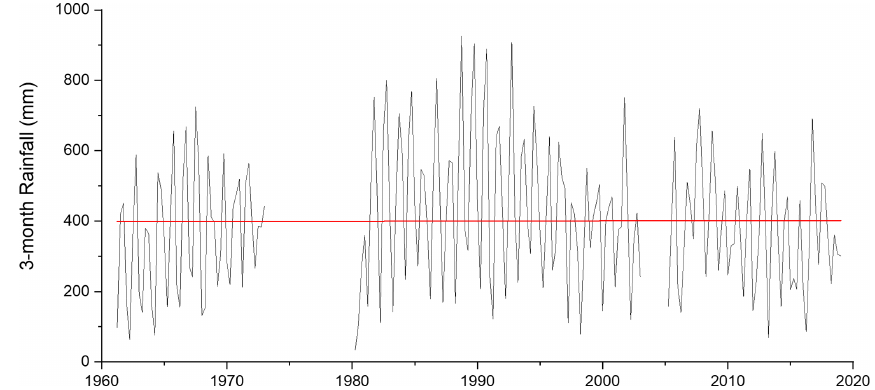
Figure 9. Mean 3-month rainfall at Kampong Cham and Chaktomuk from 1960–2019. There is no statistically significant trend in rainfall within the data period (Mann–Kendall test: p = 0.8).